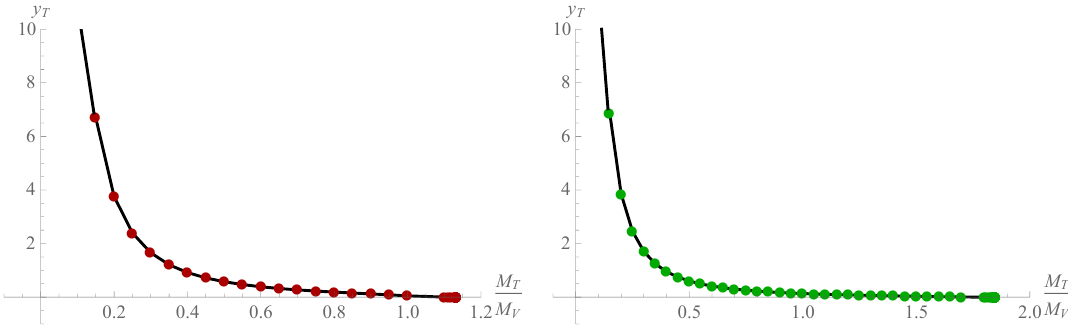
is perturbative T